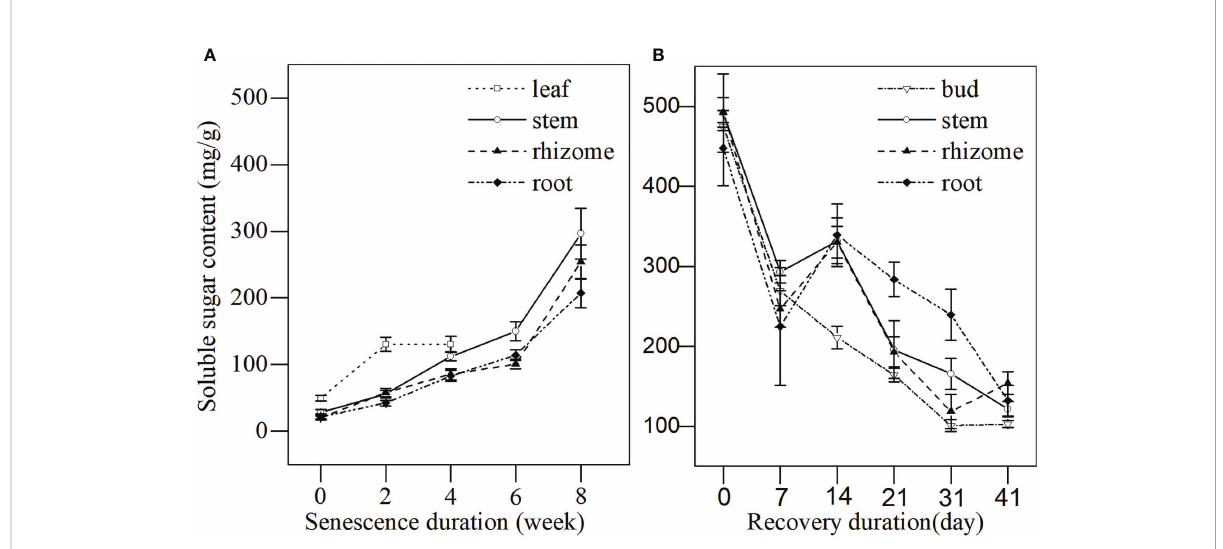
FIGURE 4 The soluble sugar content in different tissues of L. japonica during senescence and revival. Data are presented as mean ± SE. Each batch consisted of fi ve replicates. (A) Soluble sugar content during senescence, (B) Soluble sugar content during